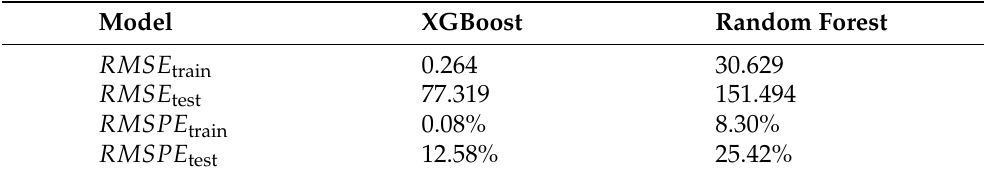
Table 6. Errors of the XGBoost and Random Forest models to compare as a simple baseline to predict hardness with sensor 2